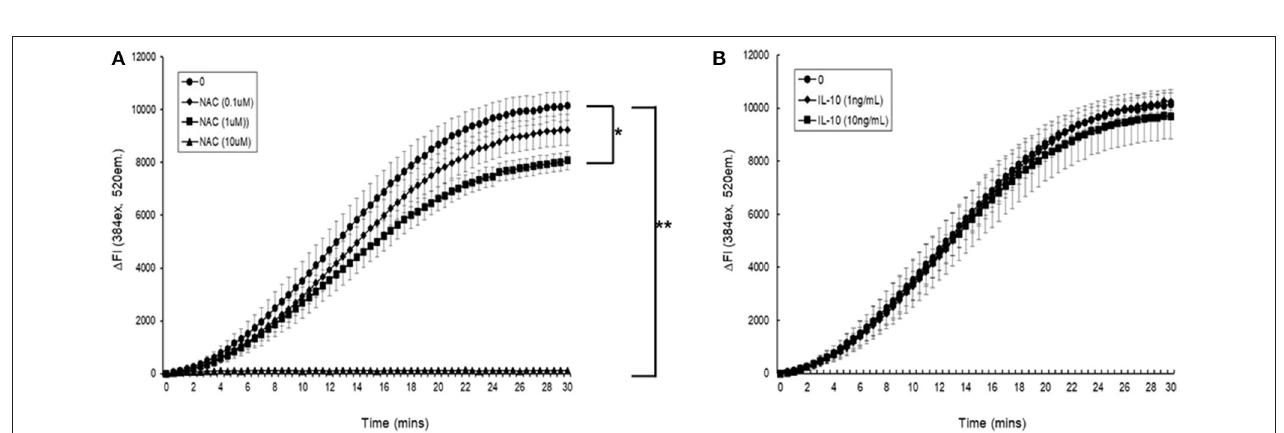
FIGURE 5 | The influence of blackcurrant anthocyanin-rich extract (BAE) or placebo (PLA) consumption 1h prior to exercise on (A) plasma antioxidant capacity (ferric reducing ability of plasma [FRAP]) on week 1 and 6 after 5 weeks of daily consumption, (B) its relationship (regression scatter plot) to plasma IL-10 levels on week 6. Results are mean ± SEM, n = 18 individuals per nutritional group. R 2 = 0.35, p < 0.009.